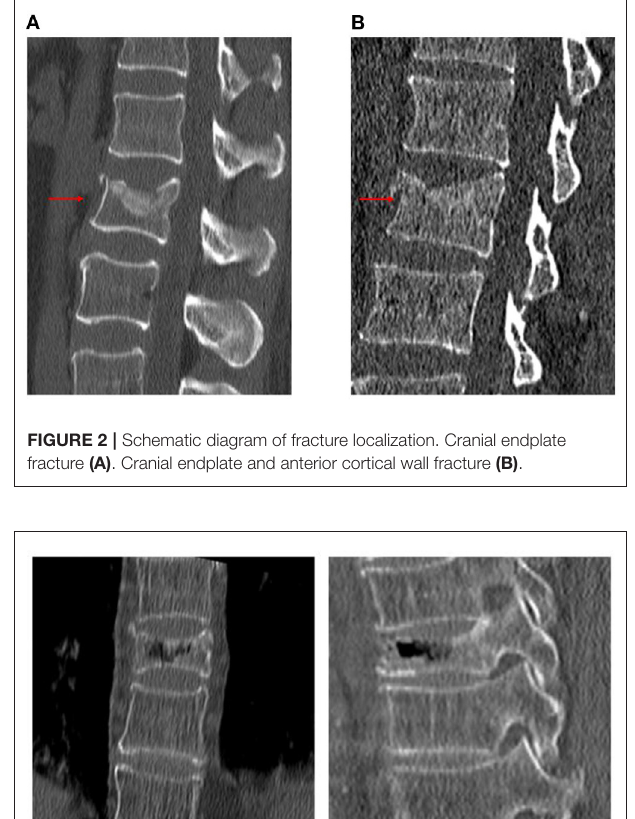
In addition, all cases were recommended a standard anti- osteoporosis treatment (calcium, vitamin D, and diphosphate) at 1 year